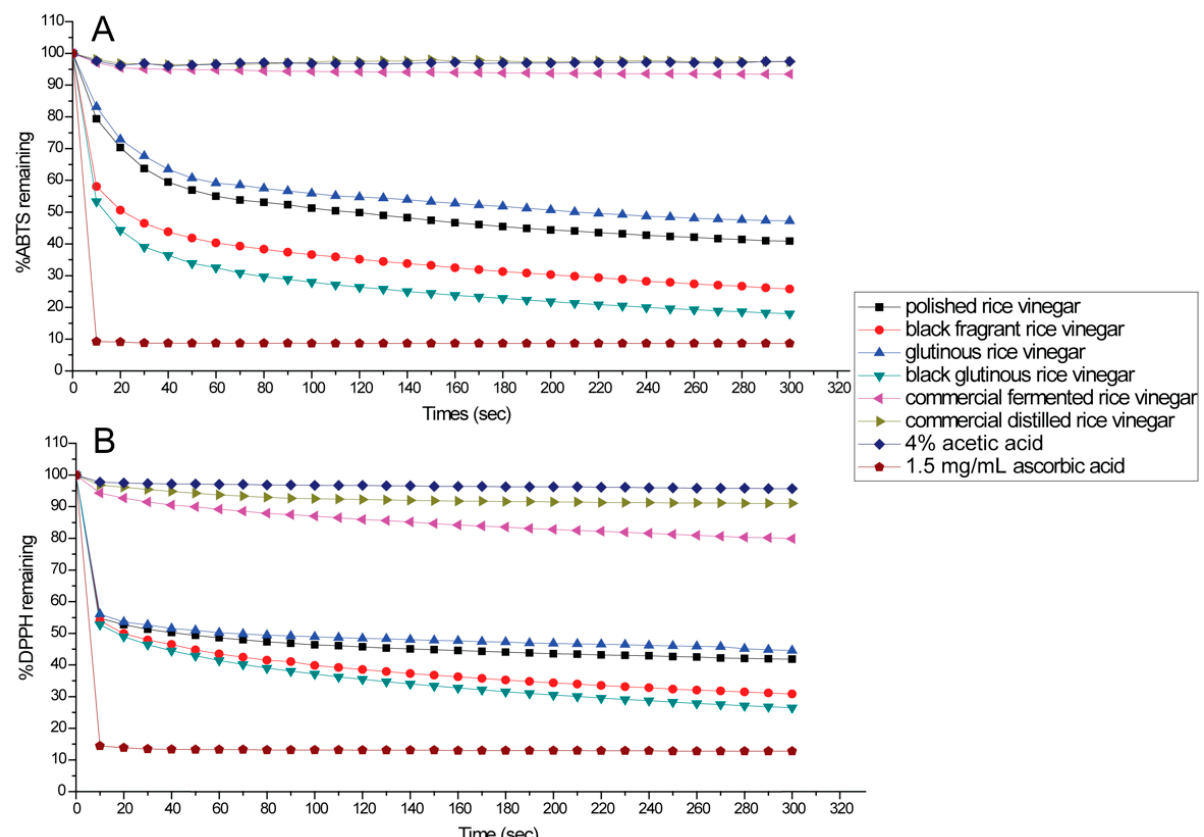
Figure 4. Antioxidant activity of rice vinegars by the ABTS method ( A ) and the DPPH method ( B ).